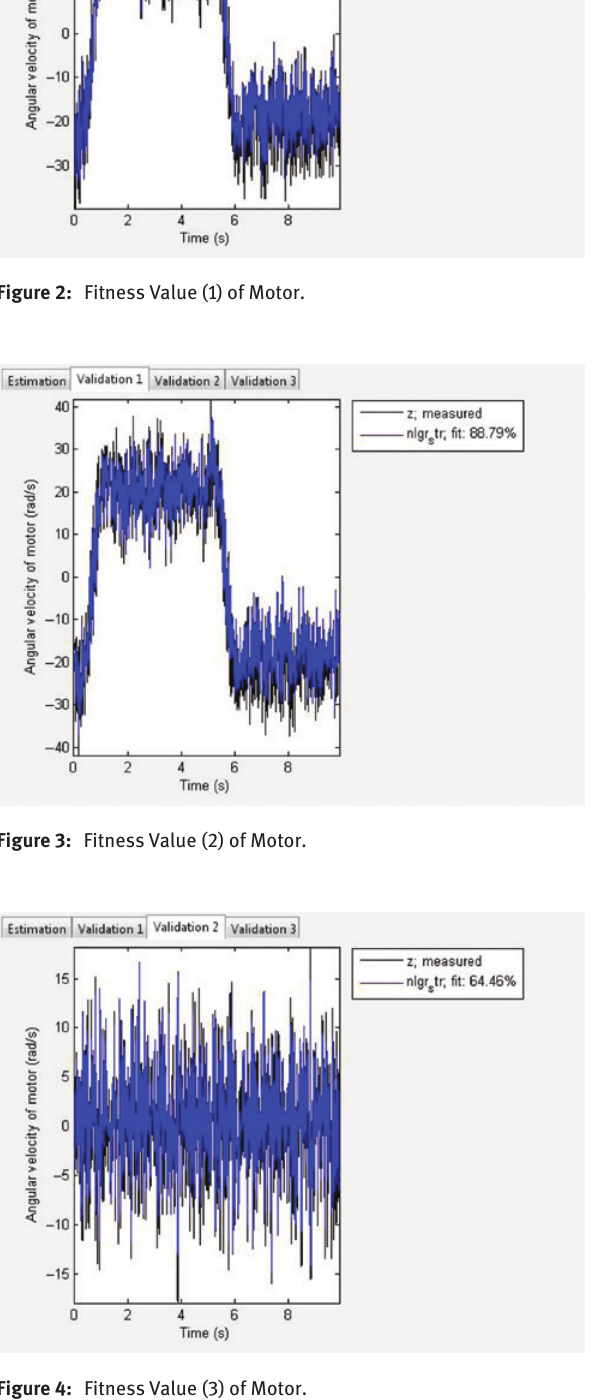
Figure 4: Fitness Value (3) of